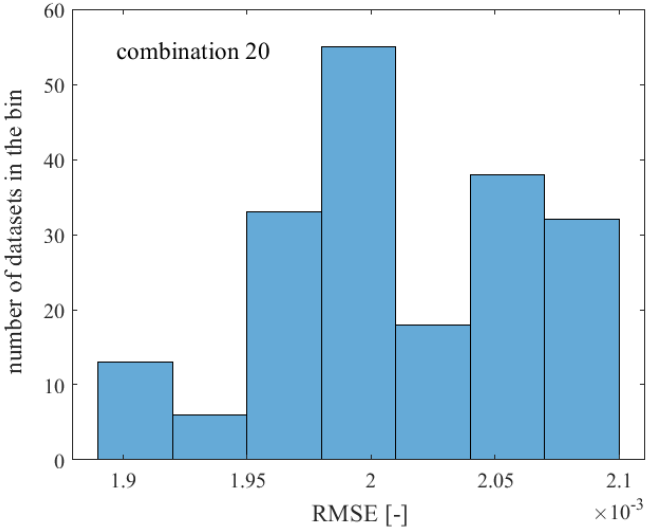
Figure 5. Histogram of RMSEs for random selected 195 datasets for testing using LSTM parameters defined in combination 20. Median RMSE value was equal 2.0076 × 10 −3 .